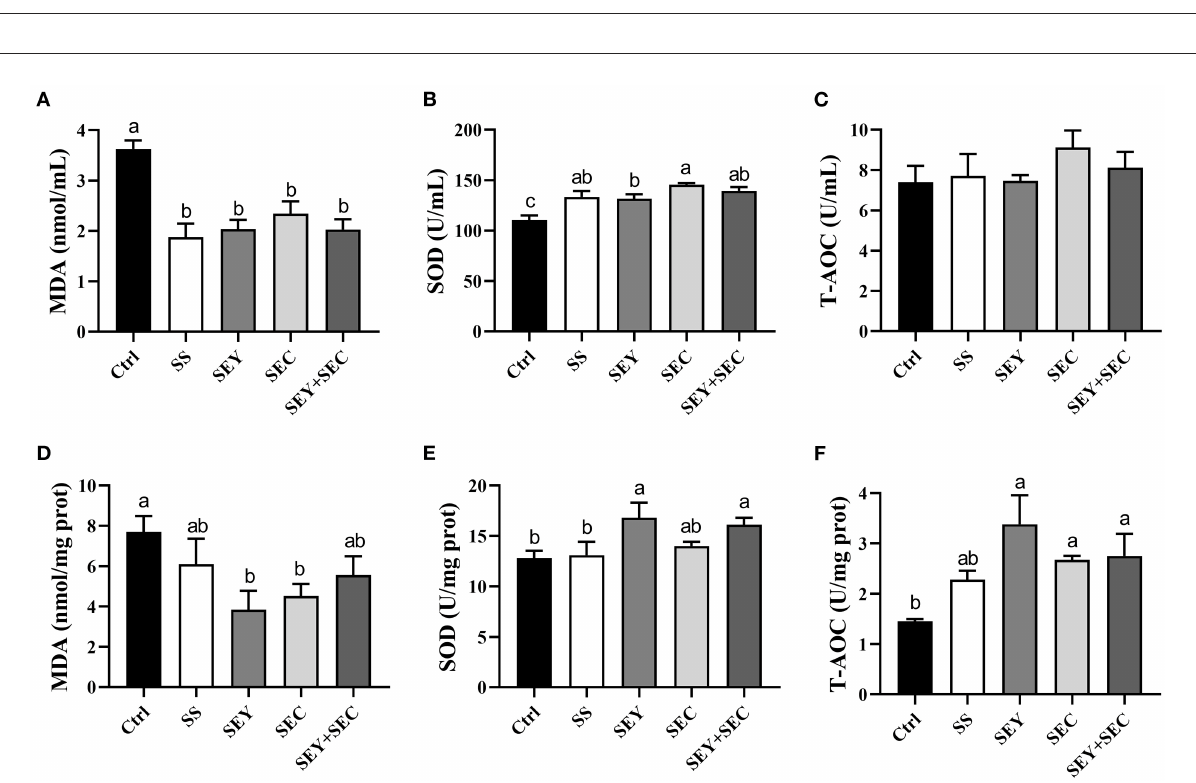
FIGURE4 Effects of different Se sources on the antioxidant parameters in serum and jejunum. (A–C) MDA concentration (A) , SOD activity (B) and T-AOC (C) in serum; (D–F) MDA concentration (D) , SOD activity (E) , and T-AOC (F) in the jejunum. Values are means ± SEM, n = 6. a,b,c Means without a common letter differ, P < 0.05. MDA, malondialdehyde; SOD, superoxide dismutase; T-AOC, total antioxidant capacity. Ctrl, control group; SS, sodium selenite; SEY, Se-enriched yeast, SEC, Se-enriched Cardamine violifolia ; SEY + SEC, Se-enriched yeast + Se-enriched Cardamine violifolia .